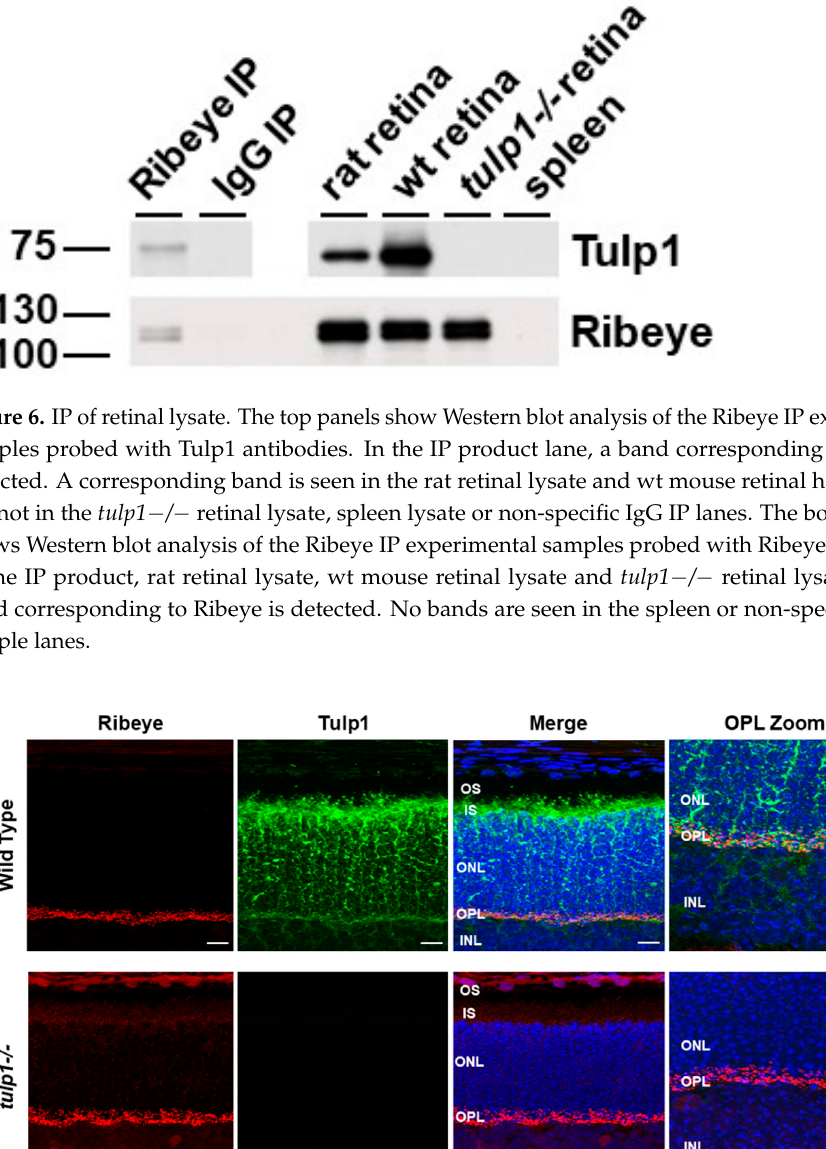
Figure 7. Immunolocalization of Ribeye and Tulp1 in P17 mouse retinas. ( A ) Wt retinal sections stained with Ribeye (red) and Tulp1 (green). ( B ) Tulp1 − / − retinal sections stained with Ribeye (red) and Tulp1 (green). Sections were counterstained with DAPI (blue). Scale bar: 50 μ m. INL, inner nuclear layer; OPL, outer plexiform layer; ONL, outer nuclear layer; IS, inner segment layer; OS, outer segment layer.